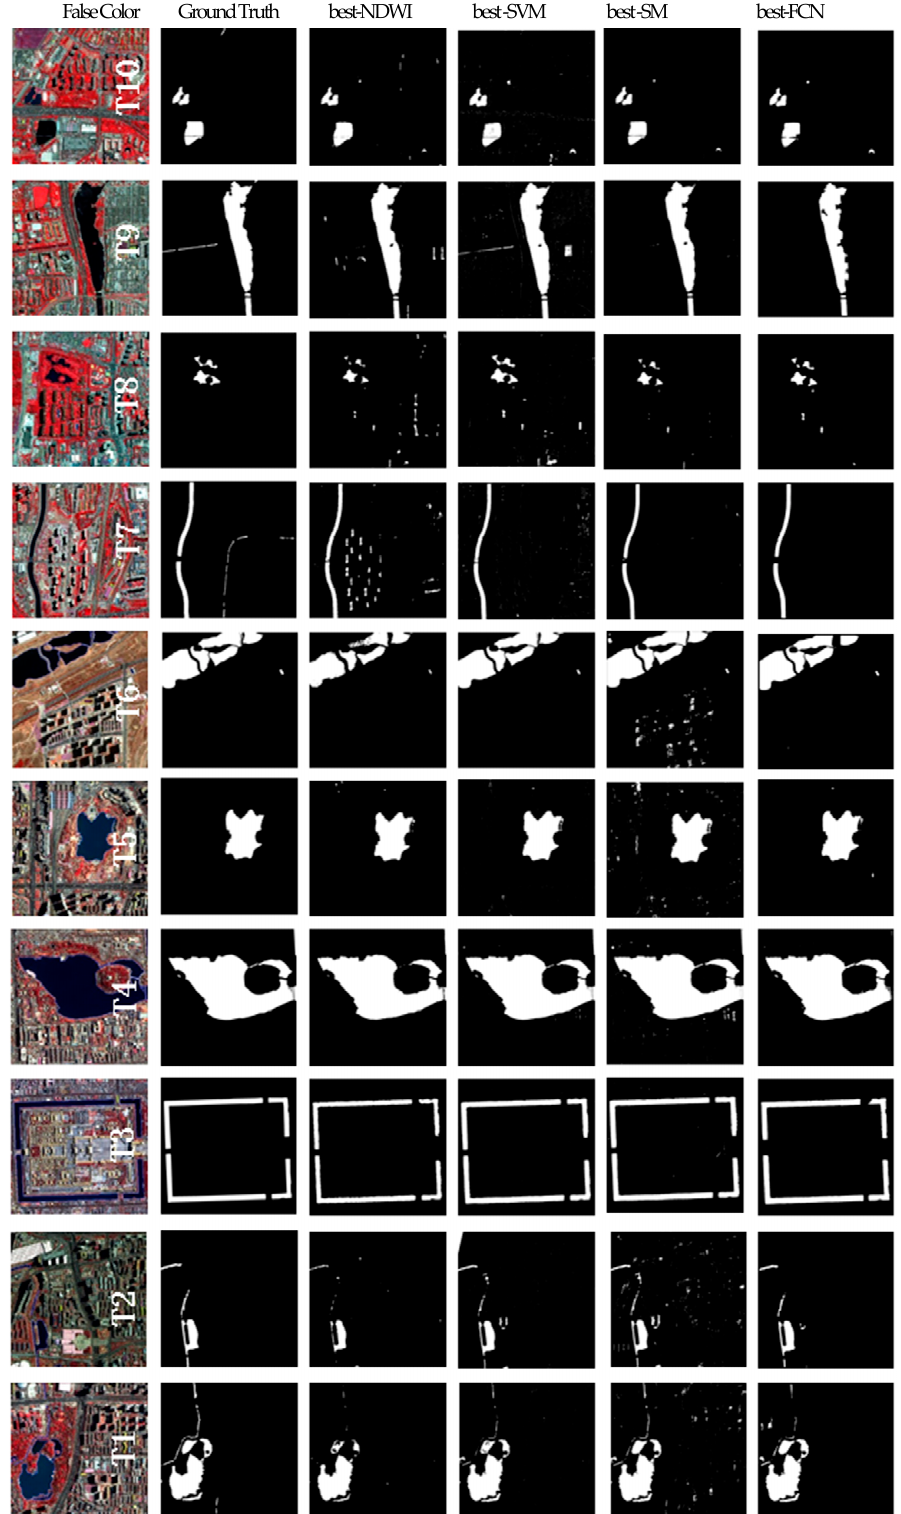
Figure 8. Illustration of false color images (column 1), ground truth (column 2) and results of T1-T10 (rows 1-10) based on best-NDWI, best-SVM, best-SM and best-FCN (columns 3, 4, 5, 6).